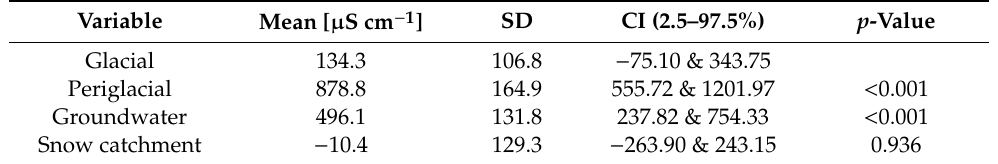
Table 2. Mean, standard deviation (SD) and confidence interval (CI) for electric conductivity of different water sources in comparison with the glacial system. Akaike weight w = 1; R 2 = 0.88. Variable Mean [µS cm −1 ] p -Value